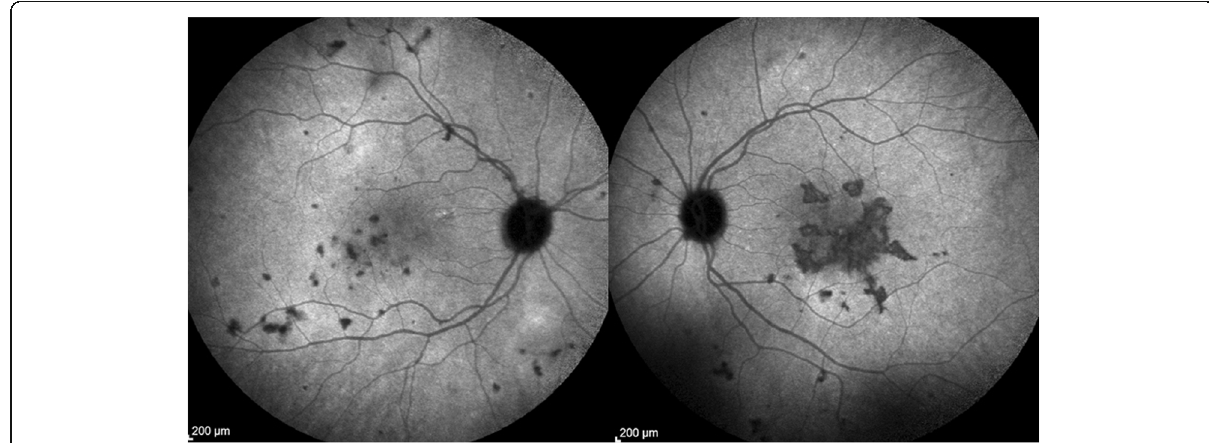
Fig. 18 Case of mixed choriocapillaritis . The right eye shows the typical features of MFC, while lesions in the left eye take the aspect of